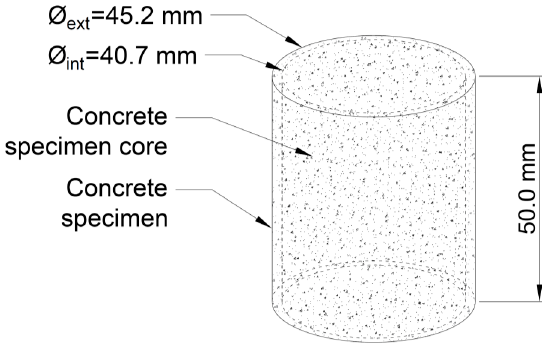
Figure 8. Portion of the concrete to be studied.